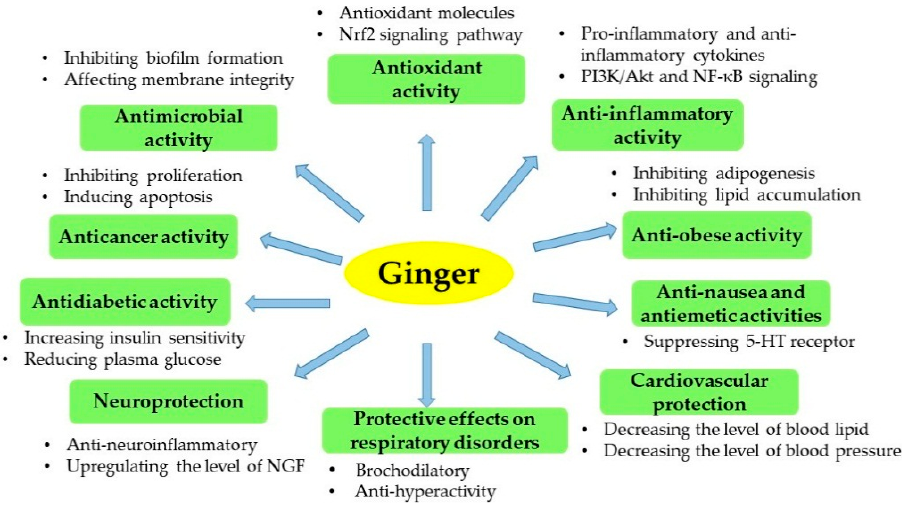
Figure 3. An overview of the bioactivities of ginger.